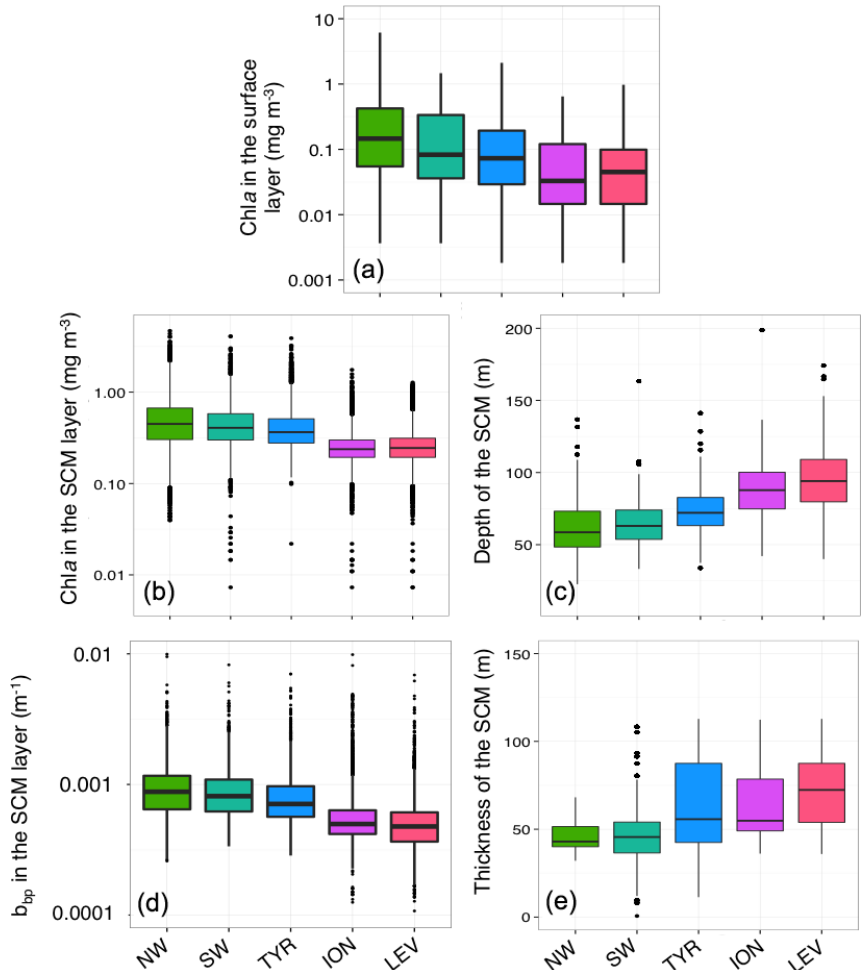
Figure 3. Box plot of the distribution of the chlorophyll a concentration (Chl a ) in the surface (a) and SCM layers (b) , the particulate backscattering coefficient ( b bp ) in the SCM layer (c) , and the depth (d) and thickness (e) of the SCM for each Mediterranean region considered in this